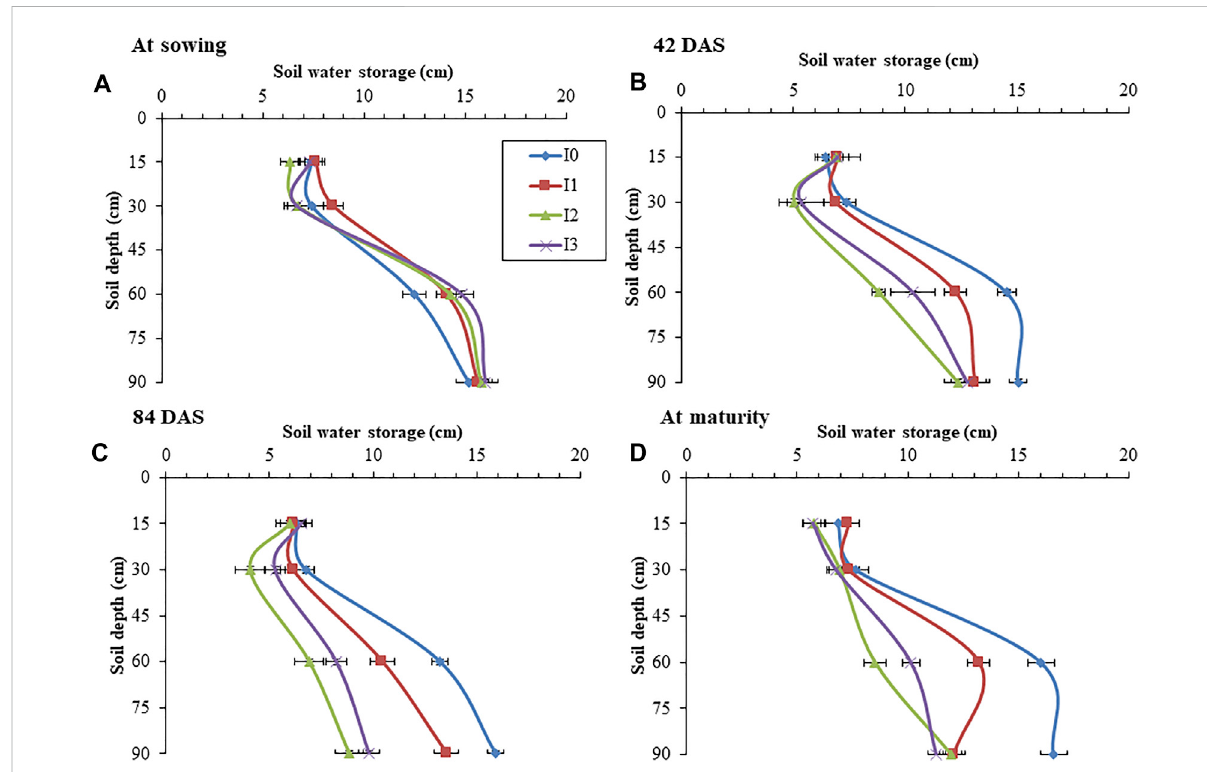
FIGURE 8 (A – D) Effect of irrigation and nitrogen regimes on soil water storage at different times and depths of sampling during the second year of study (mean ± standard error).